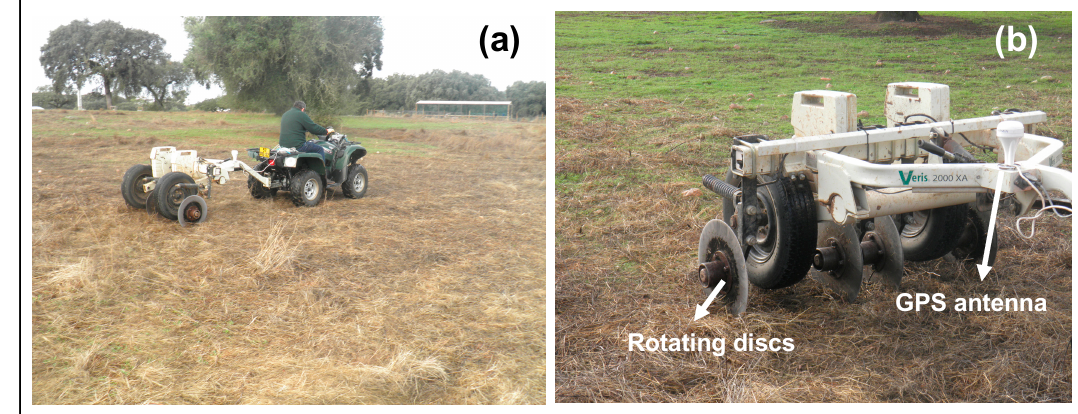
Figure 4. ( a ) Apparent soil electrical conductivity survey of the experimental field in October 2016; ( b ) Veris 2000 XA sensor.